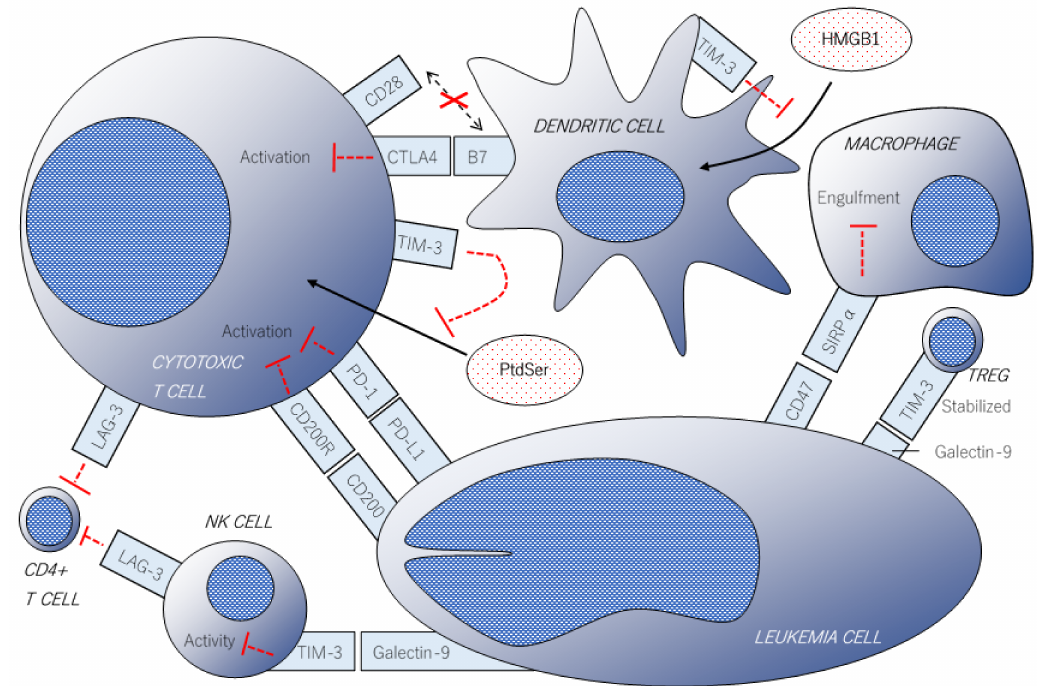
Figure 1. The scheme of immune checkpoint molecules associated with anti-leukemic immunity. Direct cytotoxicity in leukemic cells is attenuated by the binding of programmed cell death-1 (PD-1) on T cells and programmed cell death-ligand 1 (PD-L1) on cancer cells. T-cell activation via B7 family molecules on dendritic cells is canceled by cytotoxic T-lymphocyte- associated protein 4 (CTLA-4). Phagocytic activity of macrophages is dampened by the “don’t eat me” signals of CD47 on leukemic cells. Lymphocyte activation gene-3 protein (LAG-3) expressed on T cells or natural killer cells inhibit the activity of CD4-positive T cells. T-cell immunoglobulin and mucin-domain containing-3 (TIM-3) has multiple inhibitory mechanisms such as attenuation of natural killer (NK) cell activity/stabilization of regulatory T cells by binding to galectin-9 and neutralizing the pro-inflammatory effect of HMGB1 and phosphatidylserine